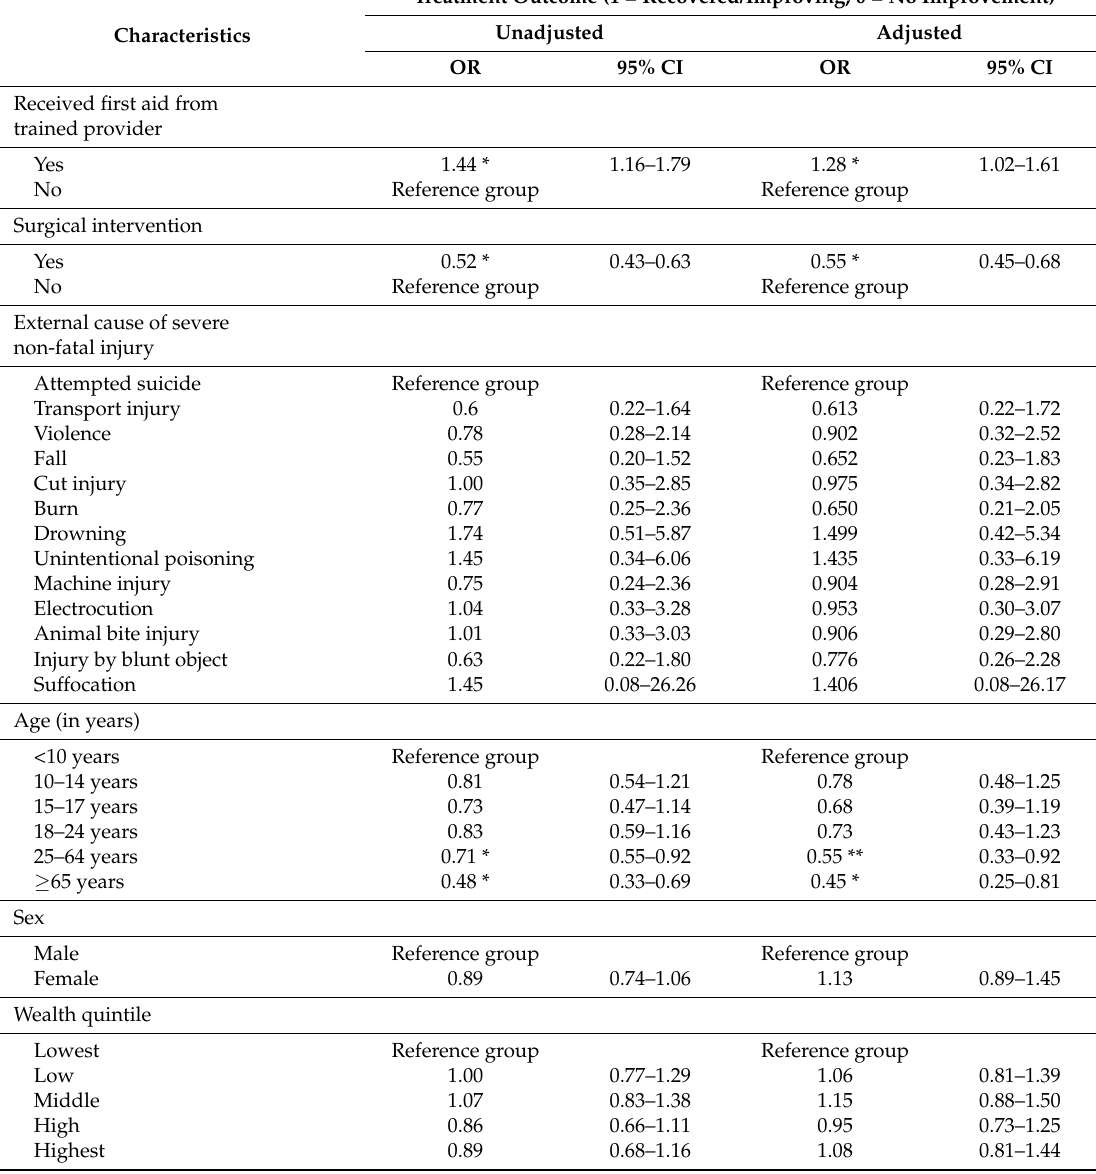
Table 6. Multivariate analysis of treatment outcomes by trained provider among severe non-fatal hospitalized injuries.